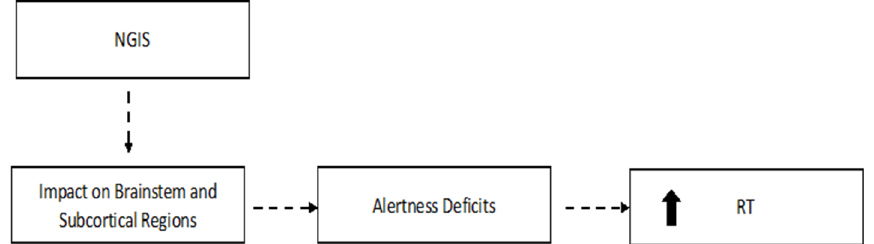
Figure 3. Hypothetical explanation for the attention deficits in the NGIS group. NGIS: COVID-19 patients without gastrointestinal symptoms; RT: reaction time. The arrow indicates an increase in the RT variable.